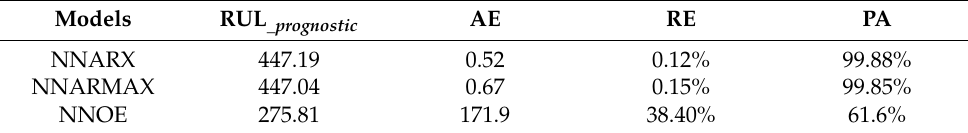
Table 5. Comparison analysis results of the proposed